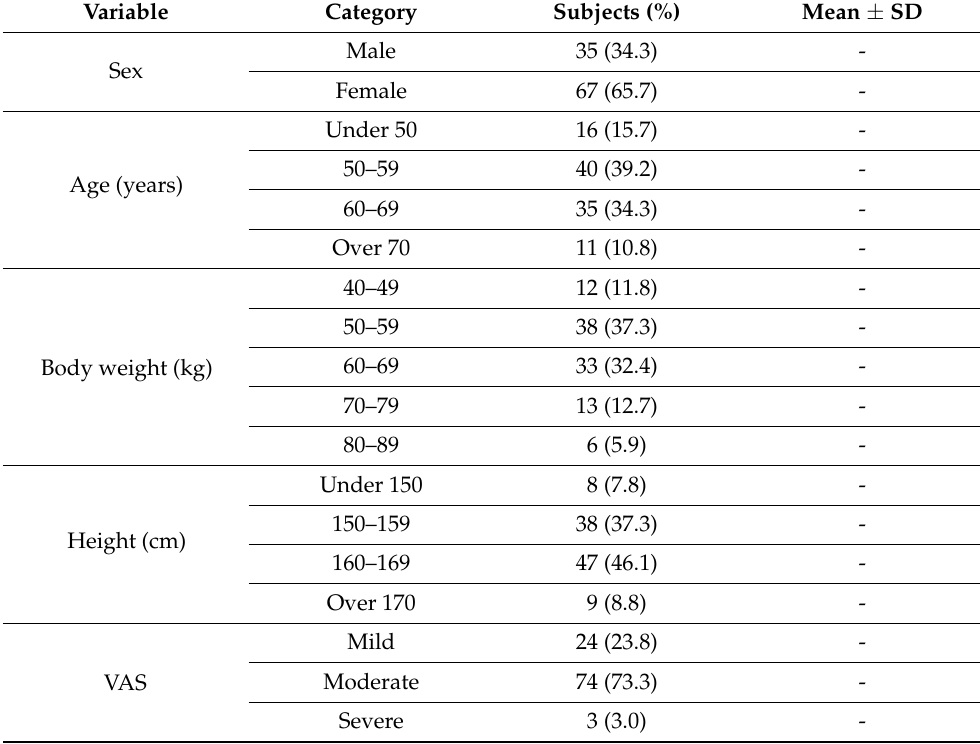
Table 1. Characteristics and descriptive analysis of the subjects ( n =